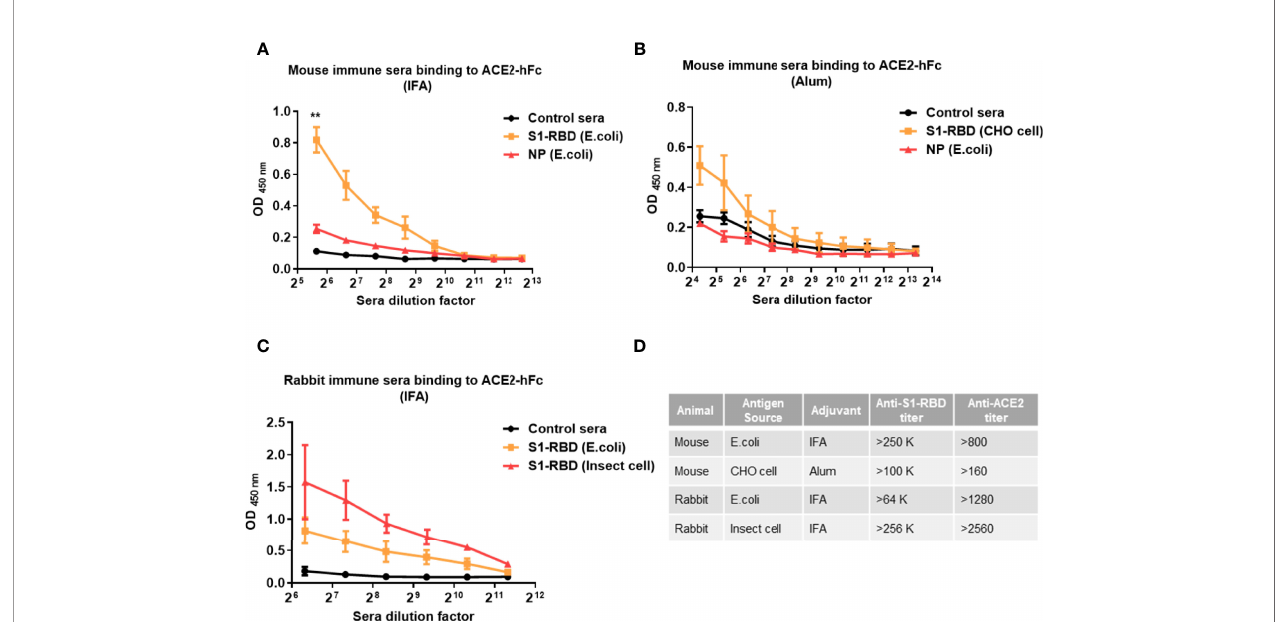
FIGURE 2 | Immunization with SARS-CoV-2 S1-RBD elicits antibodies that cross-react with human ACE2. Mice or rabbits were immunized with recombinant S1- RBD generated from different sources, such as E. coli, mammalian cells (CHO cells) and insect cells (S2), using IFA or alum as indicated. Four mice or rabbits were included in each group for N value (A – C) Different dilutions of serum antibodies binding to ACE2 from S1-RBD- or NP-immunized mice or rabbits were measured by ELISA as indicated. In addition, normal mouse or rabbit sera were used as control sera. (D) Comparison of antibody titers against S1-RBD or ACE2-hFc in different immune sera samples measured by ELISA. The titer indicates that the highest dilution of end-point titers of sera that still showed a positive reaction. All statistical data are presented as the means±S.Ds. from at least two independent experiments.